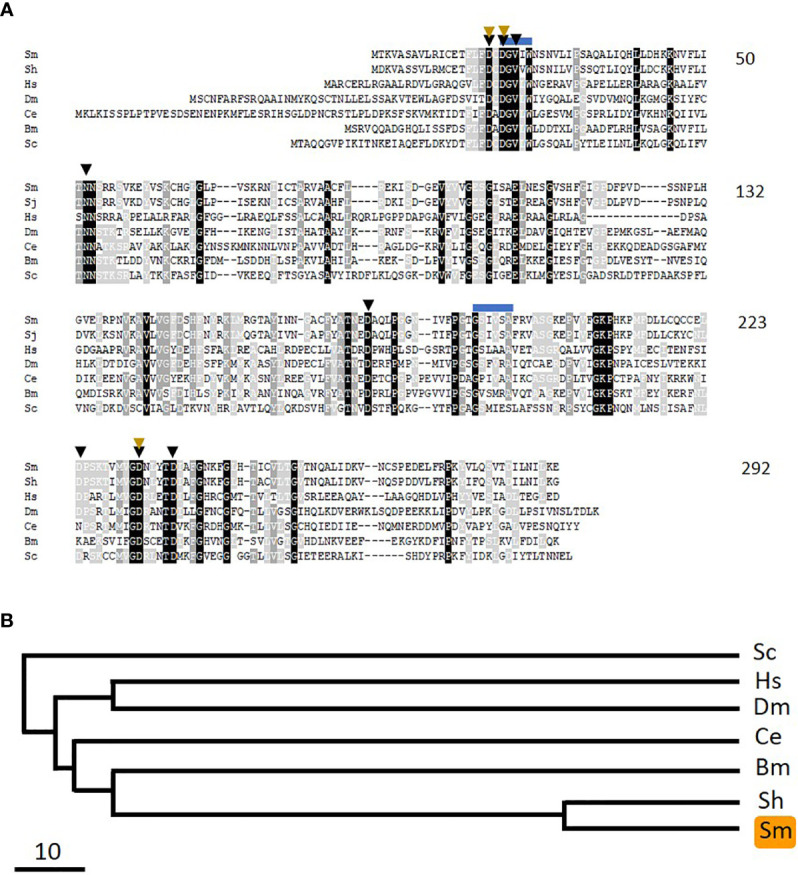
Alignment of SmPLP-Ph with other members of the pyridoxal phosphate phosphatase protein family. Sm, Schistosoma mansoni (GeneBank accession number MW148602); Sh, Schistosoma haematobium (CAX69944); Hs, Homo sapiens (NP_064711); Dm, Drosophila melanogaster (NP_649015.2); Ce, Caenorhabditis elegans (NP_504511); Bm, Brugia malayi (XP_001895356); Sc, Saccharomyces cerevisiae (AJV03114). Residue shading is as described in
Figure 6
. Predicted active site residues binding are indicated by black arrowheads and those involved in metal (Mg) binding by brown arrowheads. Blue lines indicate potential myristoylation sites. Numbers at right are an amino acid count for the S. mansoni protein. (B) Phylogenetic tree (absolute distance) of selected pyridoxal phosphate phosphatases generated by multiple sequence alignment using UPGMA (unweighted pair group method with arithmetic mean). The designations (and accession numbers) of the homologs compared are as in (A).